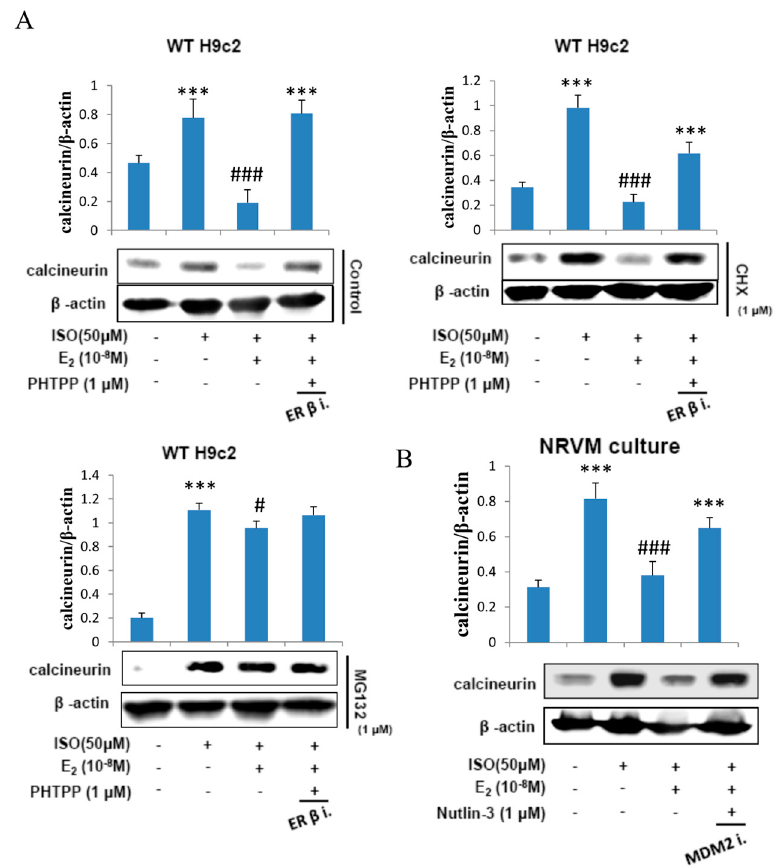
Figure 5. E2 enhances calcineurin protein degradation via estrogen receptor β . ( A ) H9c2 cells were